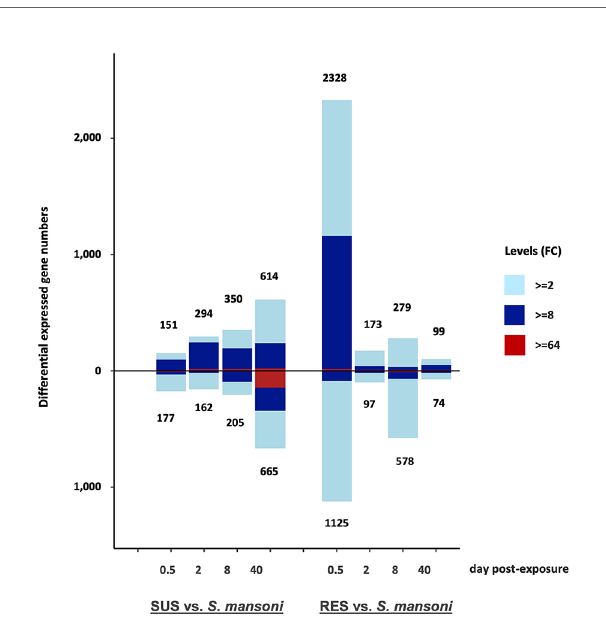
FIGURE 6 | Bar graph indicating numbers of DE genes in the 8 different groups of SUS and RES snails exposed to S. mansoni (in Table S2 ). The number of up-regulated genes is shown above the zero line and the number of down-regulated genes is shown below the zero line. The horizontal axis shows days post-exposure for both strains. Numbers outside of each bar represent the total DE genes, either up-or down-regulated. The three colors in each bar indicate fold changes (FC) among comparisons: light blue 2-8; dark blue 8-64; and red greater than 64-fold.